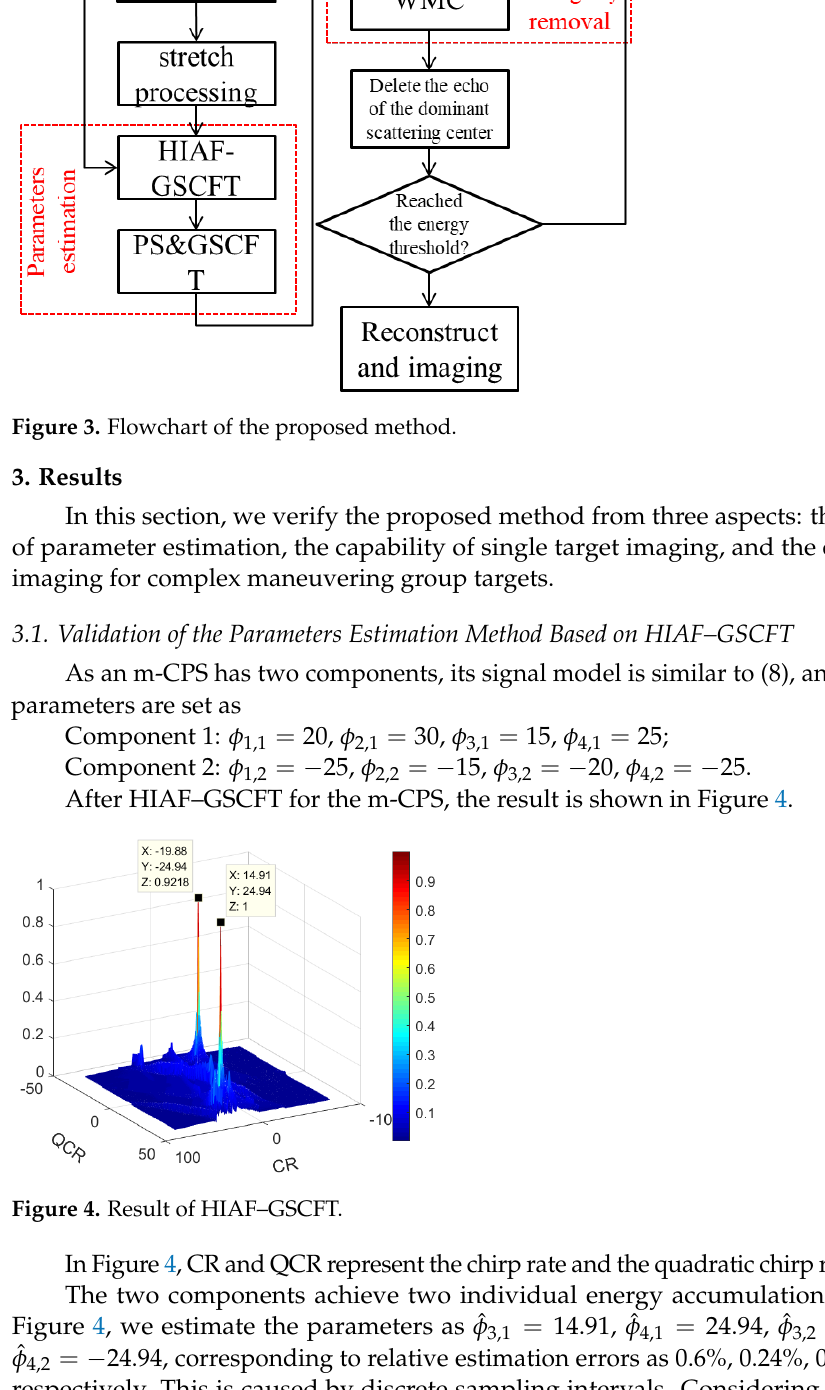
( b ) Figure 5. Results of GSCFT: ( a ) using the estimated parameters of component 1 to compensate for the echo; ( b ) using the estimated parameters of component 2 to compensate for the echo.